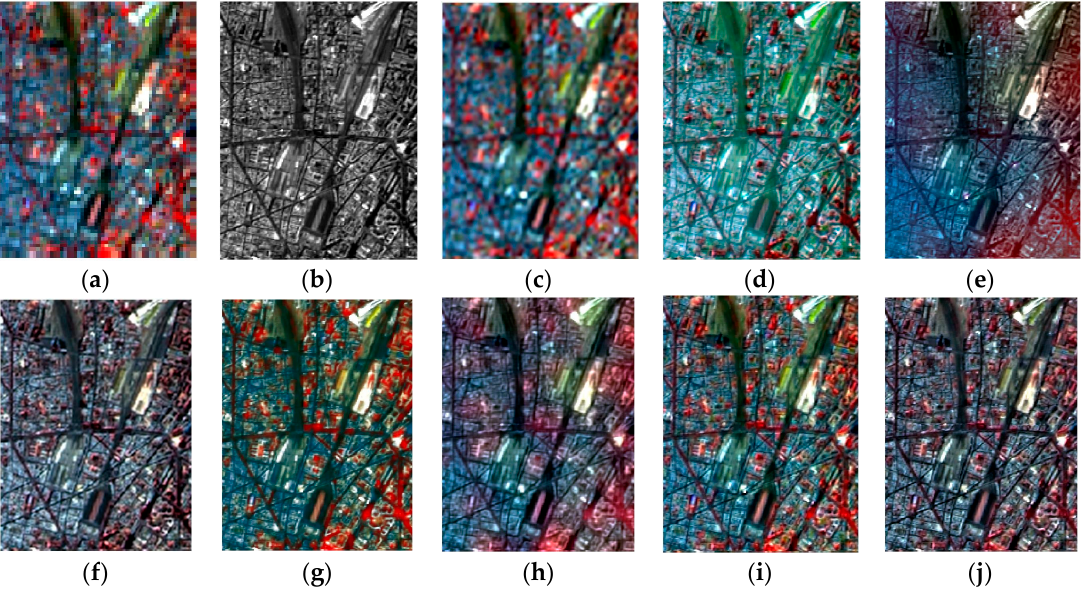
Figure 11. Fusion results obtained by each method for Hyperion dataset. ( a ) HS image; ( b ) PAN image; ( c ) Interpolated HS image; ( d ) PCA; ( e ) GFPCA; ( f ) BT; ( g ) CNMF; ( h ) BSF; ( i ) MGH; ( j ) STF.